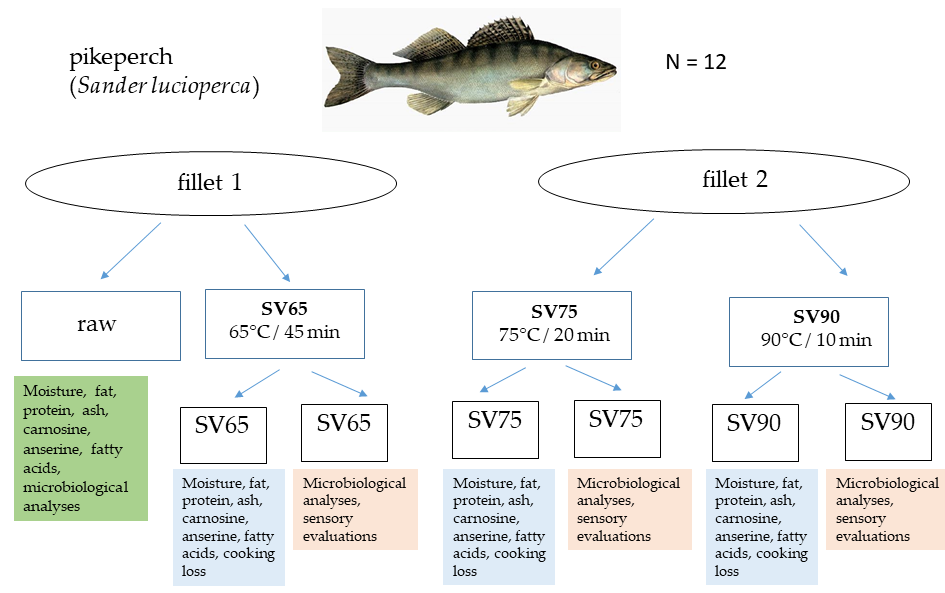
Figure 1. The experiment